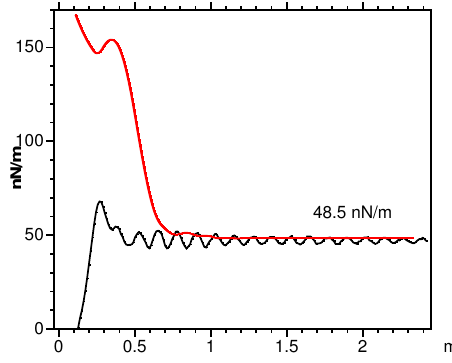
Figure 5. Run By: same as Fig. 2, but with B y = 30 000nT.